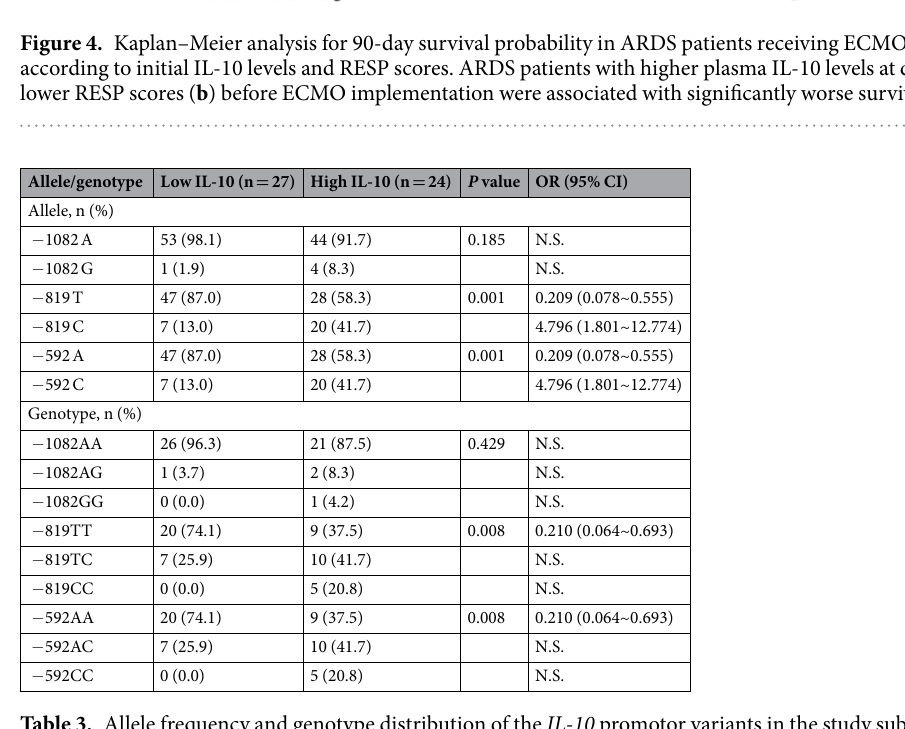
Table 3. Allele frequency and genotype distribution of the IL-10 promotor variants in the study subjects according to their plasma IL-10 levels at day 0. All the P values represent χ 2 or Fisher’s exact test results. OR, odds ratio; CI, confidence interval. N.S.,